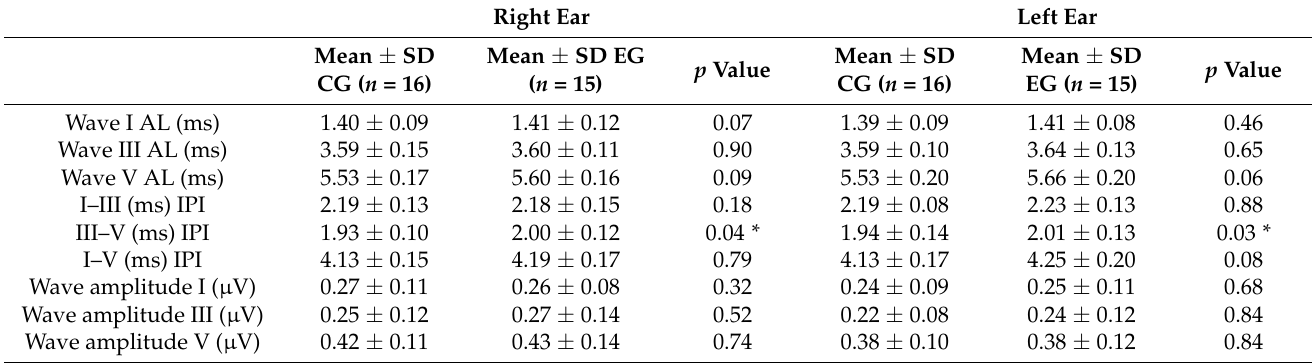
Table 3. Mean (+/ − one standard deviation) of auditory brainstem response measurements by ear and exposure group. The asterisk * denotes significant differences at the p < 0.05 level between study groups. Right